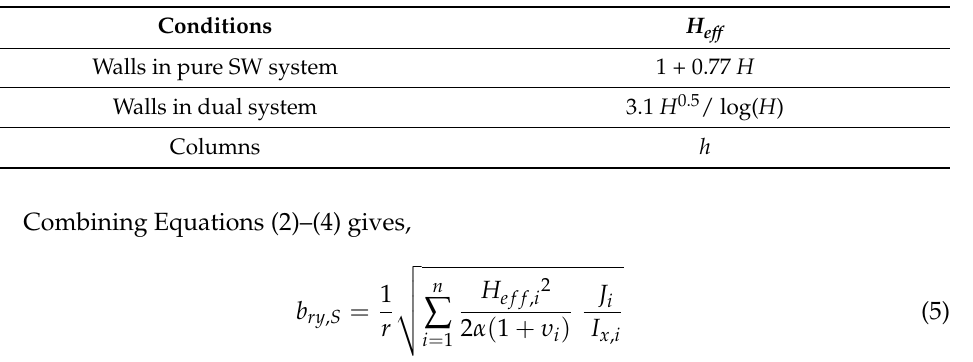
Table 1. Effective height ‘ H eff ’ in term of the total height of building ‘ H ’ and storey height ‘ h